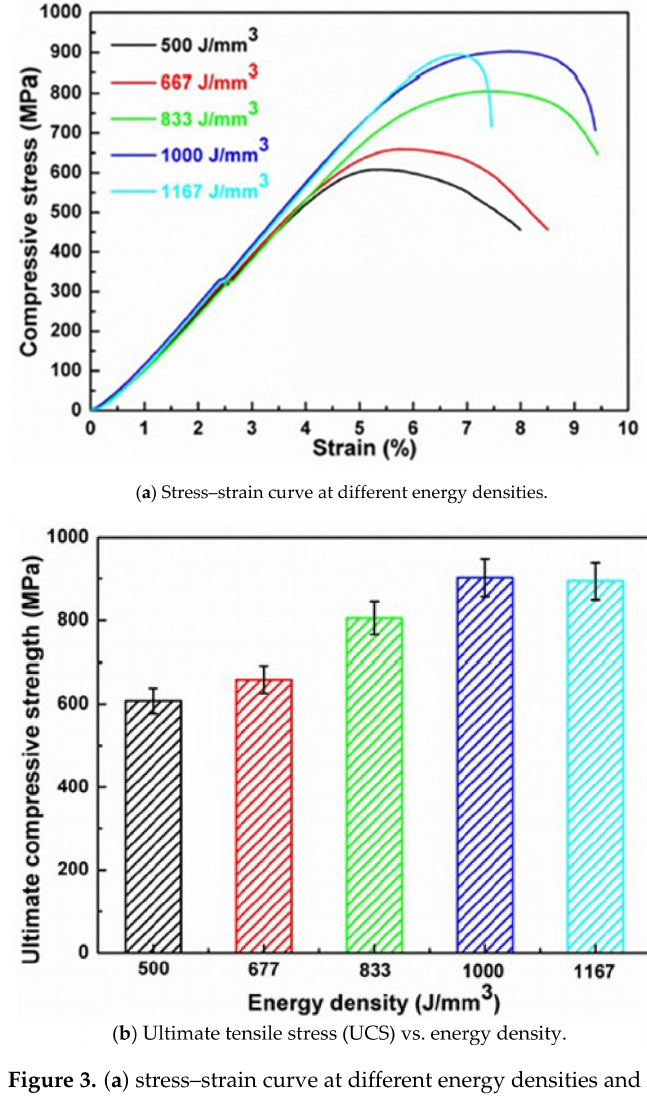
Figure 3. ( a ) stress–strain curve at different energy densities and ( b ) ultimate tensile stress (UCS) vs. energy